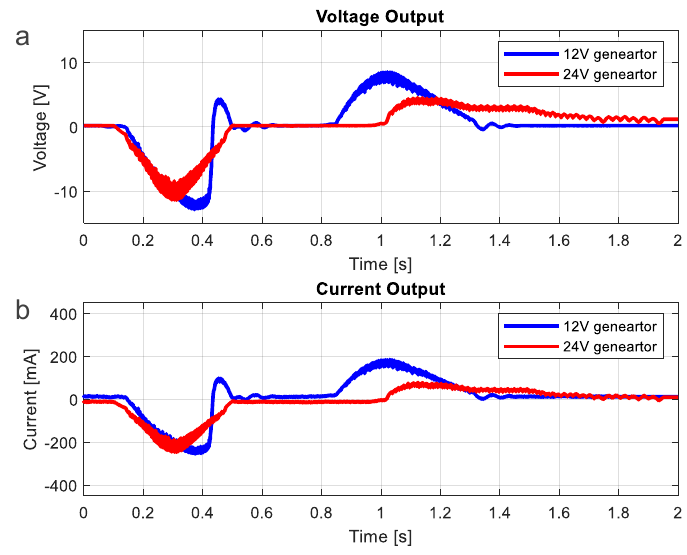
Figure 12. Comparison Voltage and Current of Lead-Screw Model with 12– and 24–V-DC Generator. ( a ) Voltage of Lead-Screw Model. ( b ) Current of Lead-Screw Model. Table 6. Energy per footstep produced by the DC generators for various rated load resistances.